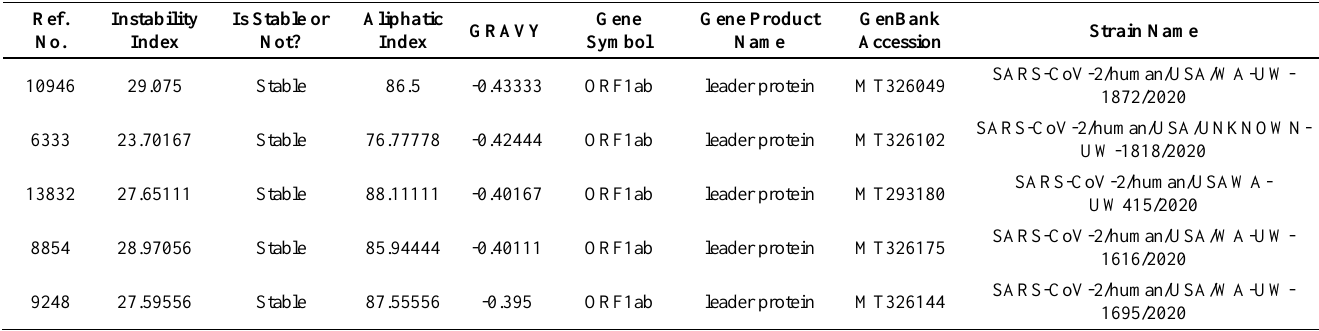
Table 2. Physicochemical property analysis for SARS-CoV-2 against the top five viral proteins having the lowest GRAVY scores and confirmed stability out of the 14,534 proteins obtained from ViPR database Ref.